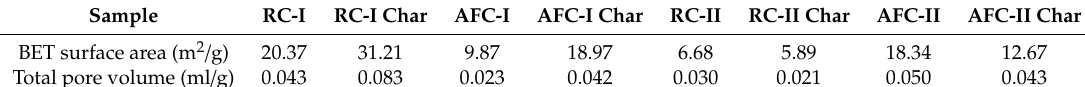
Table 2. BET surface areas and total pore volume of the selected samples.